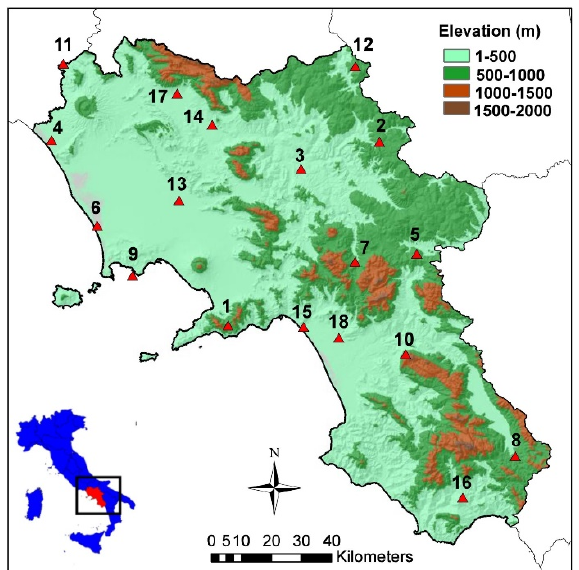
Figure 1. Study area and relief map of the region along with the ground weather station sites.